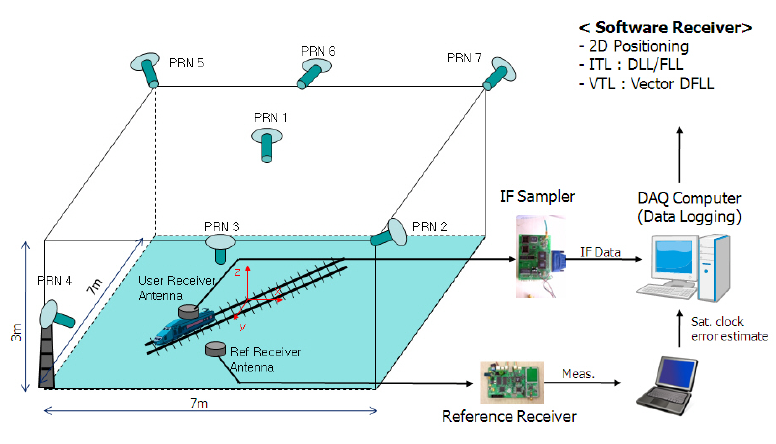
Figure 14. Test environment.